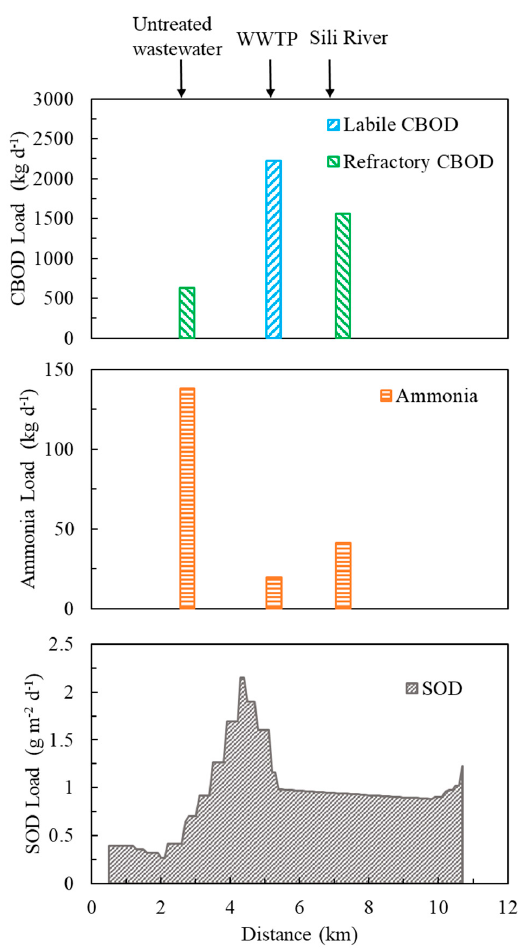
Figure 2. Pollutant loadings of the Nanfei River.